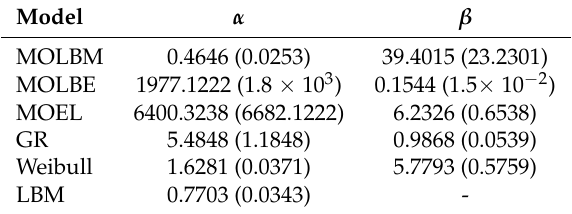
Table 13. Estimates and standard errors (in parentheses) of the parameters for Data set 4.